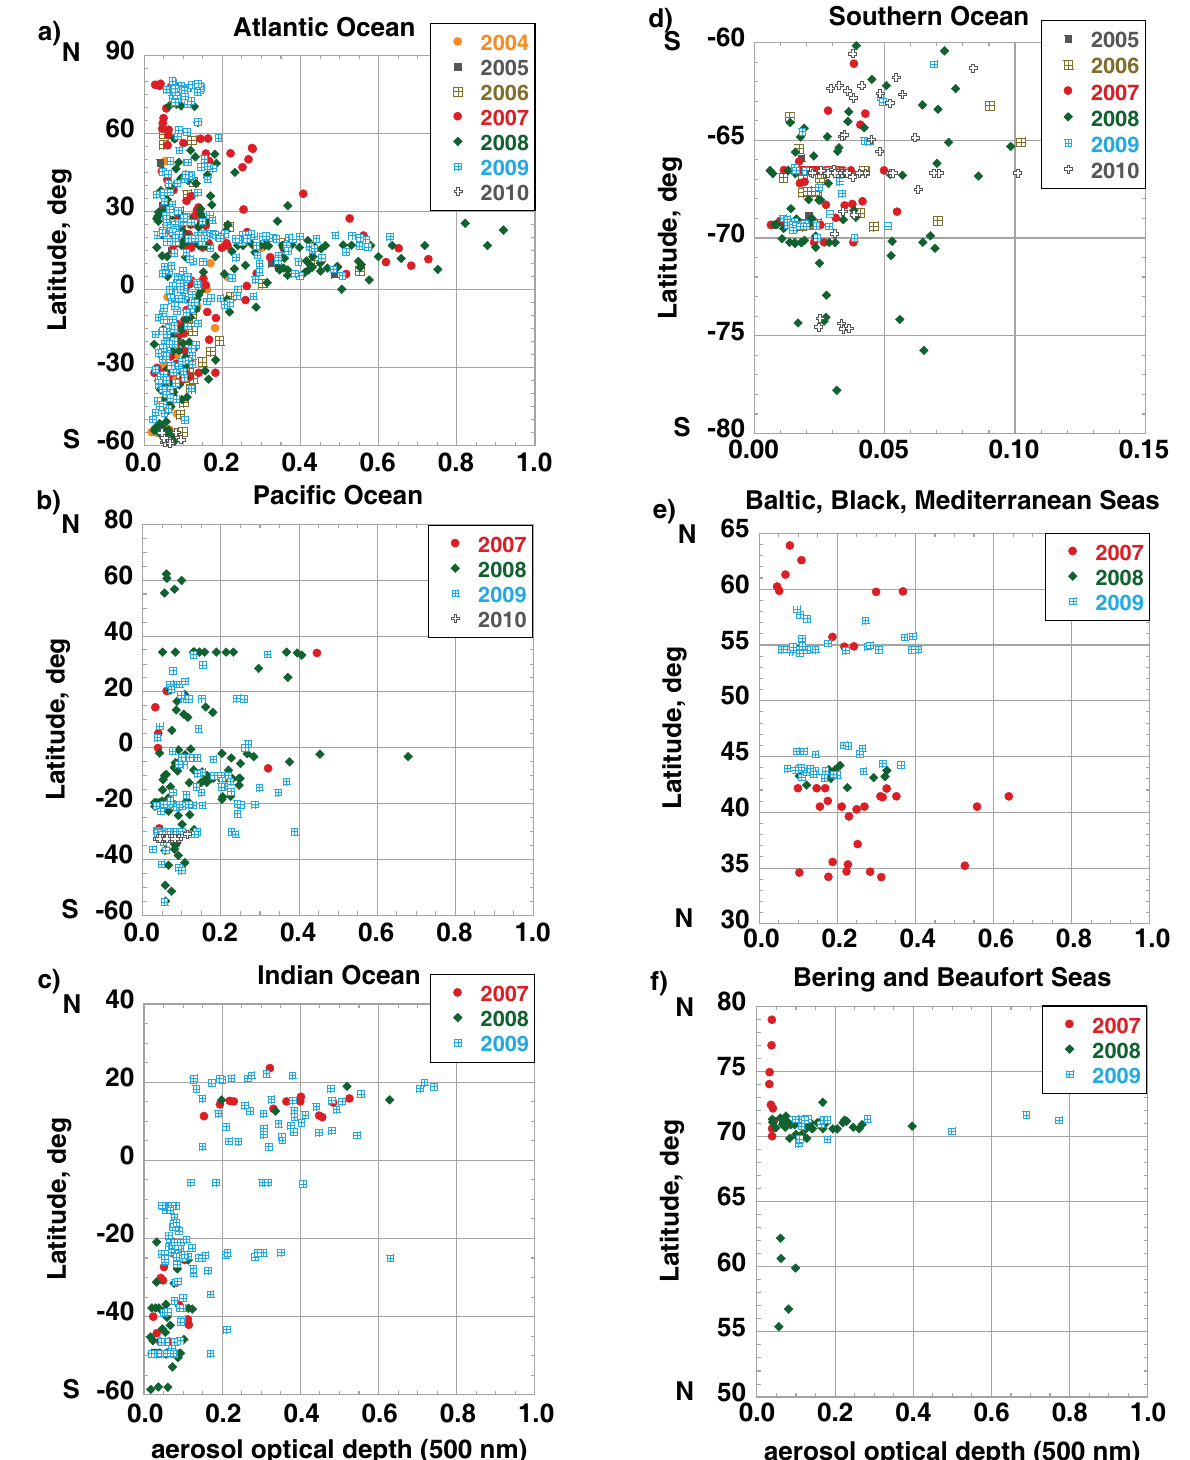
Fig. 3. Latitudinal dependence of daily averaged aerosol optical depth in the Atlantic Ocean (a) , Pacific Ocean (b) , Indian Ocean (c) , Southern Ocean (d) , Baltic, Black, and Mediterranean Seas (e) , Bering and Beaufort Seas (f)